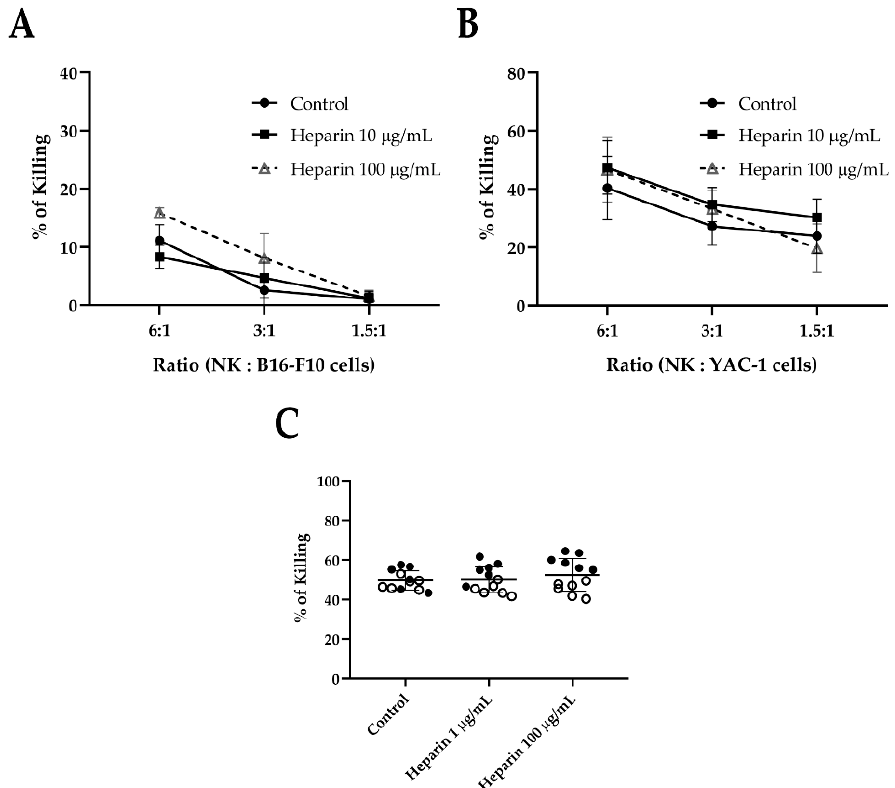
Figure 3. Heparin does not increase the killing capacity of NK cells. ( A , B ) NK cells isolated from C57BL / 6 mice were cultured in the presence of 20 ng / mL of rIL-15 and heparin (10 or 100 µ g / mL). After 24 h, NK cells were incubated for 4 h with previously Calcein AM-stained B16-F10 ( A ) or YAC-1 cells ( B ). Killing quantification was determined by the intensity of fluorescence in the supernatant and compared to control of each experiment. Each symbol in the scatterplots represents the average of three biological replicates (presented as mean ± SEM). Two-way ANOVA was used to compare di ff erences between groups. ( C ) NK cells isolated from human peripheral blood mononuclear cells were cultured in the presence of rIL-15 (50 ng / mL), with or without heparin (1 or 100 µ g / mL). After 24 h, NK cells were labeled with CTV and co-cultured with A375 cells (ratio 4:1—NK:A375 cell). After 4 h, cells were stained with Annexin V-Fluorescein isothiocyanate (FITC) and propidium iodide and evaluated by flow cytometry. Dead tumor cells were considered CTV - , Annexin V + , and / or PI + . Each point represents technical replicates from two independent experiments (represented by full and empty symbols; presented as mean ± SEM). An unpaired t -test was used to compare di ff erences between groups, with p < 0.05.